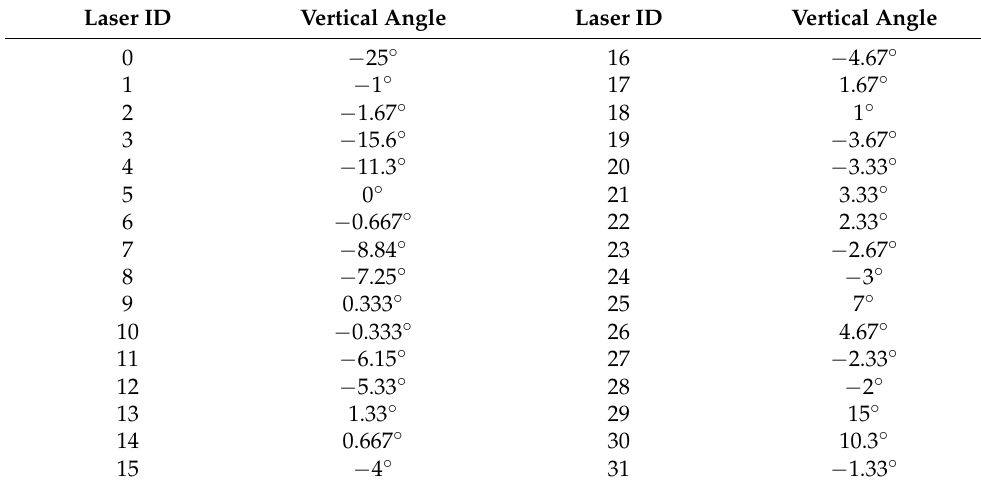
Table 1. Laser-ID-sequence list of LiDAR.